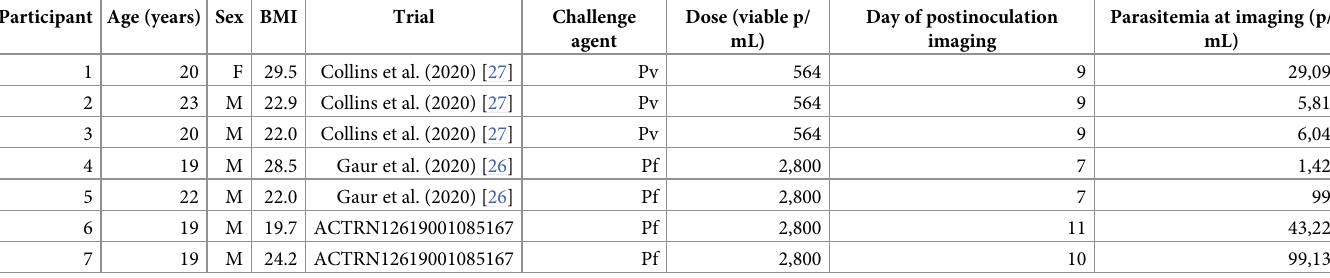
Table 1. Study population information.